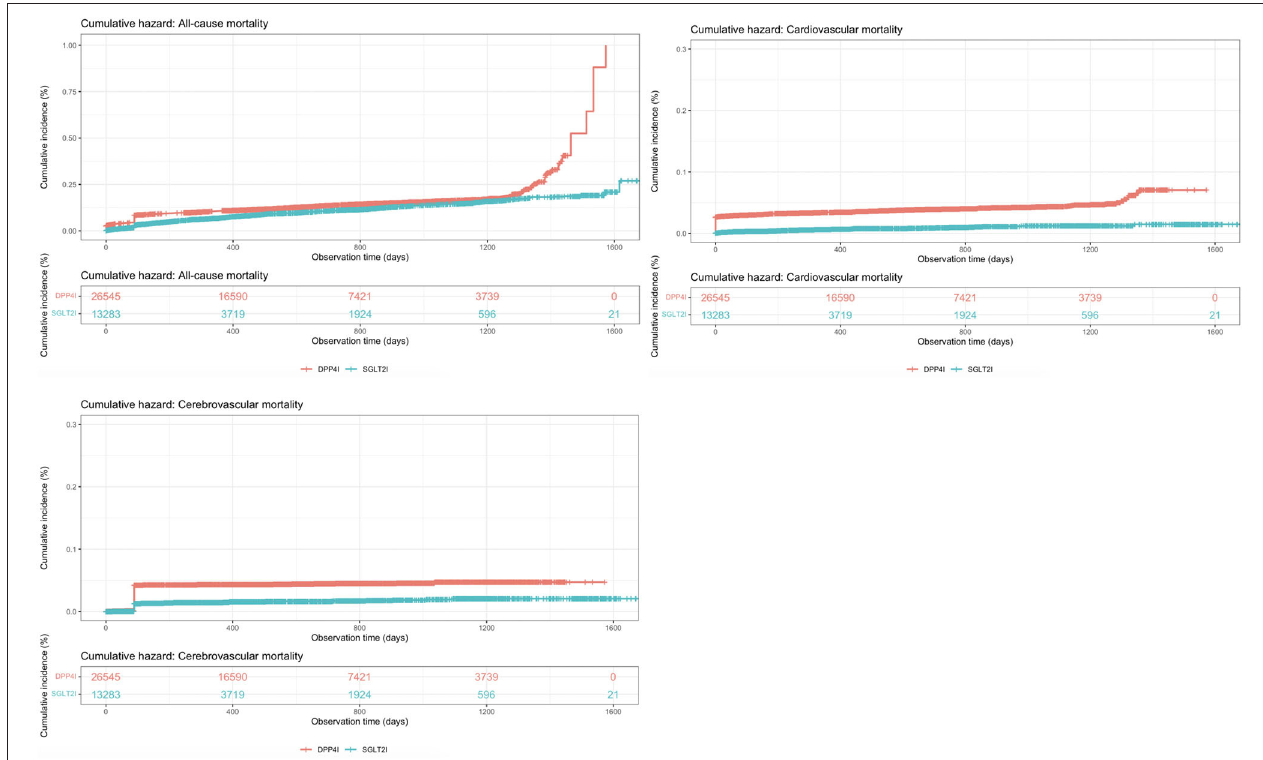
FIGURE 3 | Cumulative incidence curves for mortality outcomes stratified by the drug use of SGLT2I and DPP4I after propensity score matching